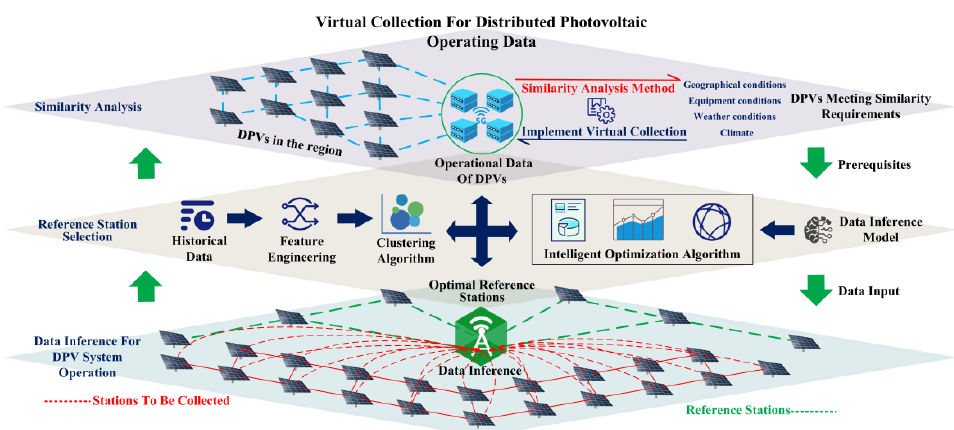
Figure 3. Schematic diagram of the DPVS virtual collection process.